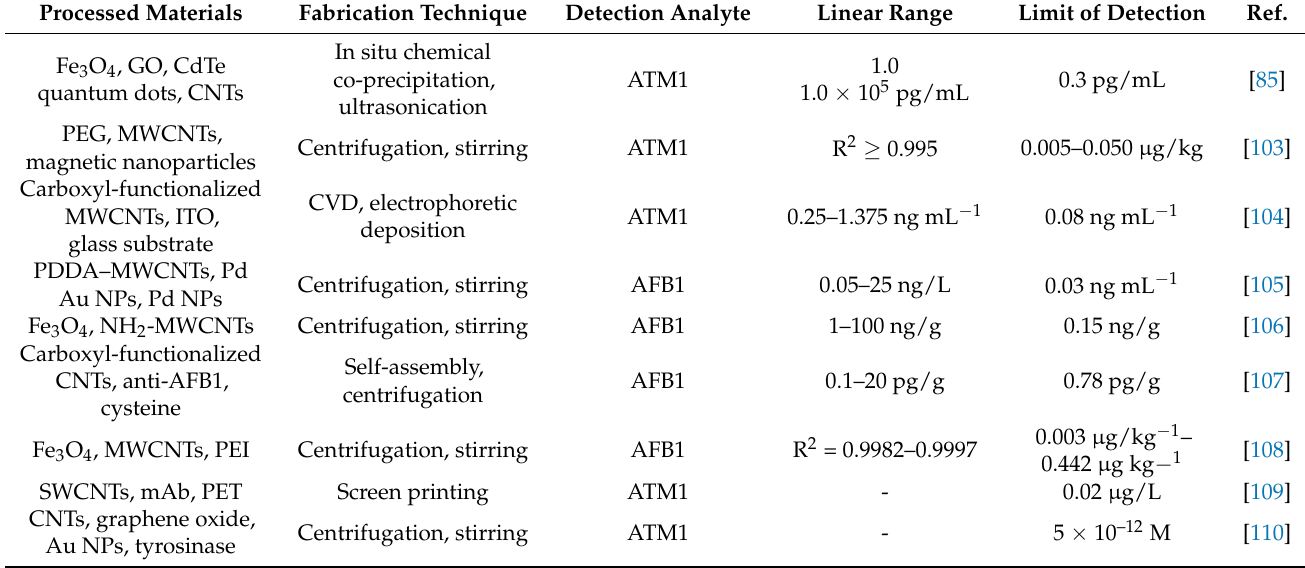
Table 3. Comparison of the performances of the CNT-based sensors for the detection of ATM1 and AFB1 compounds. Processed Materials Fabrication Technique Detection Analyte Linear Range Limit of Detection